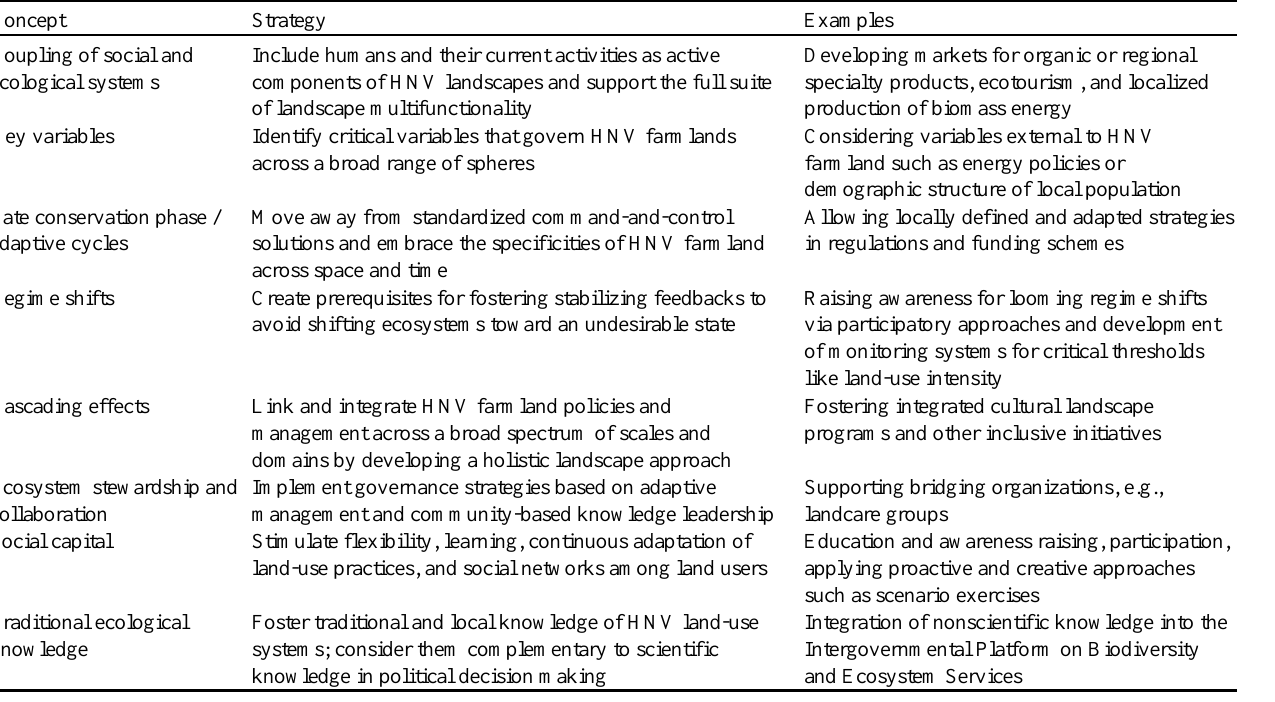
Table 1 . Strategies to maintain HNV (high-nature-value) farmland as derived from eight components of the resilience